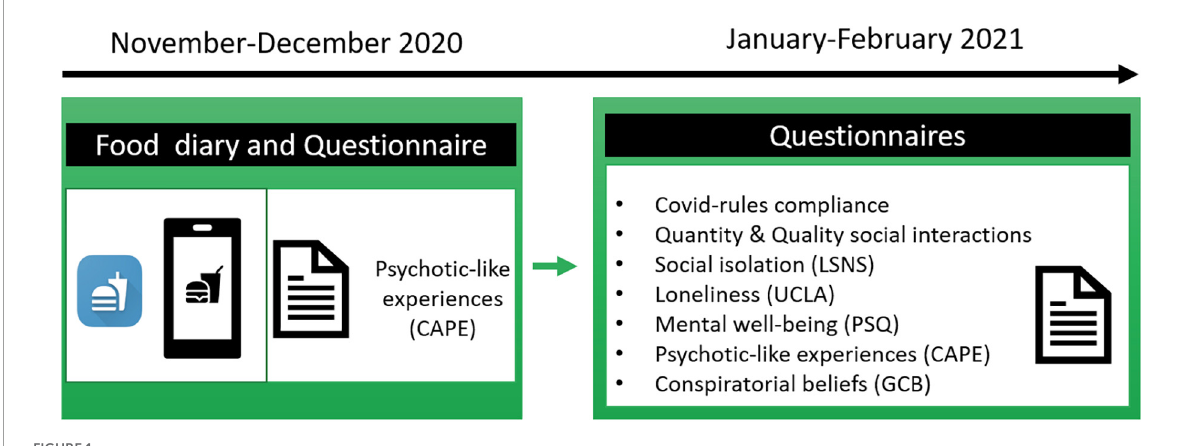
FIGURE1 Study outline. Participants first answered a questionnaire assessing psychotic-like experiences (PLEs) and completed a daily food diary for 7 days via a smartphone app. Subsequently, they completed questionnaires measuring social isolation, conspiratorial beliefs, mental well-being, PLEs, demographics among